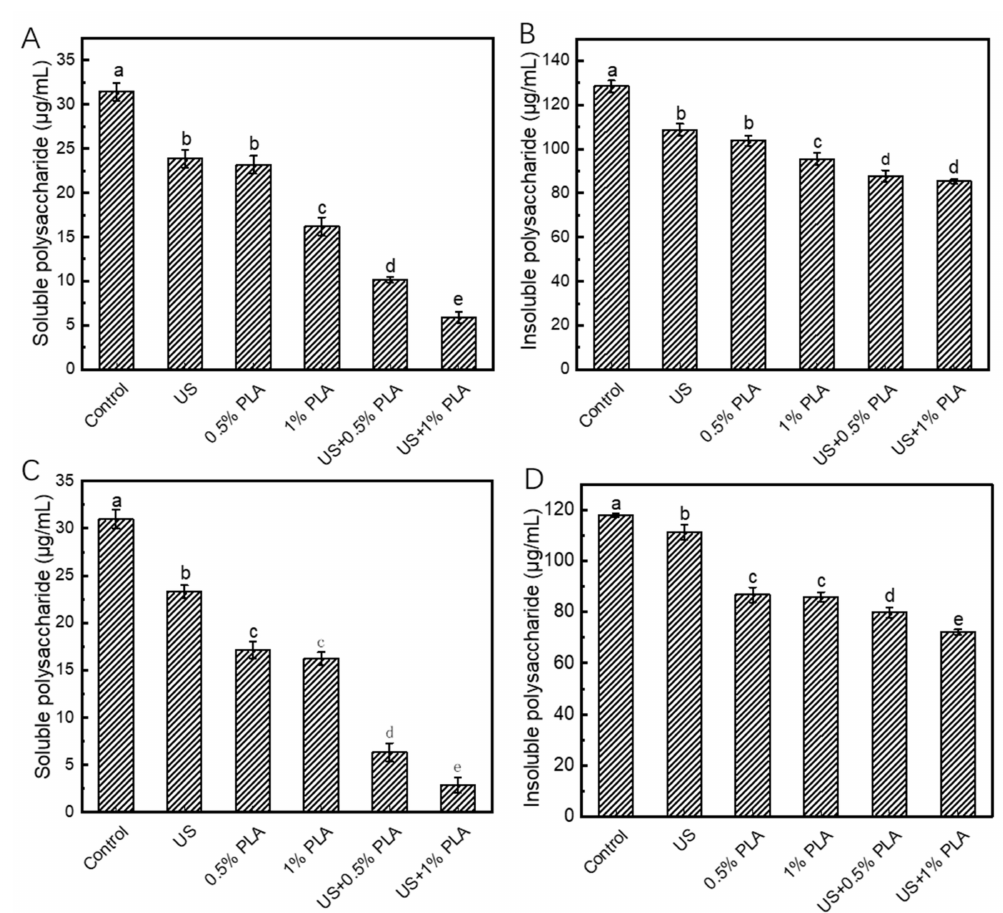
Figure 1. Changes in the contents of extracellular polysaccharides in S. aureus ( A , B ) and S. enteritidis ( C , D ) biofilms after different treatments. Different lower cases indicate significant difference ( p < 0.05). US, ultrasound; PLA, phenyllactic acid.